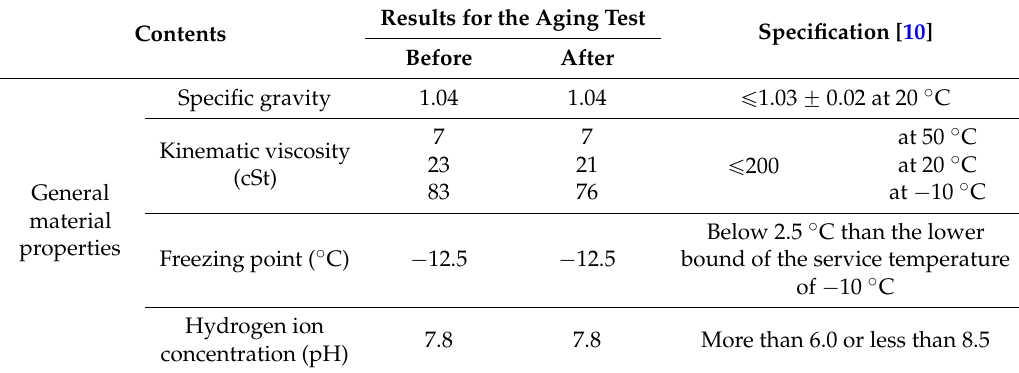
Table 4. Comparison of the general material properties for the synthetic surfactant foam of